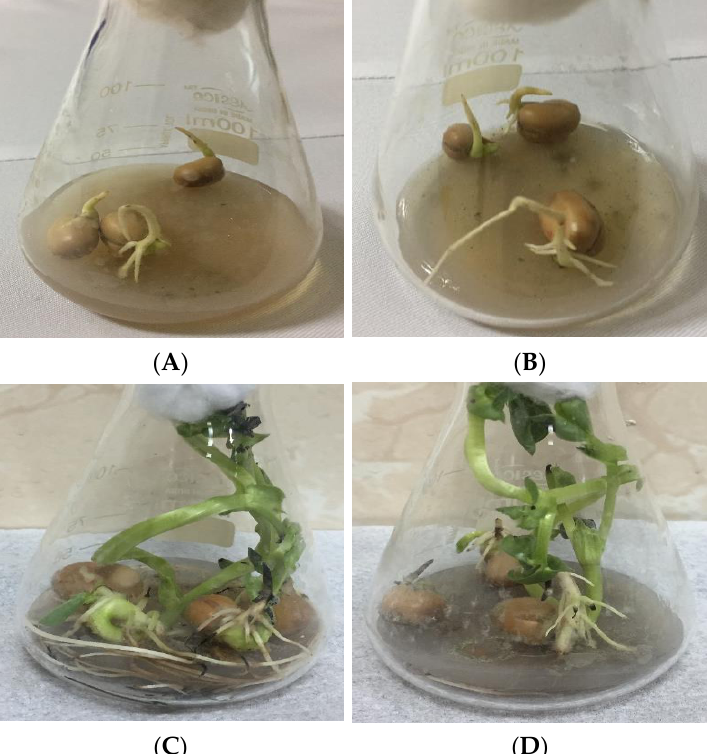
Figure 5. Effect of nano-metal complex on Vicia faba seedlings grown in Earlenmeyer flasks containing 2% water agar. ( A ) control after 4 days; ( B ) treated seeds with nano-metal complex (20 ppm) after 4 days; ( C ) control after 20 days; ( D ) treated seeds with nano-metal complex (20 ppm) after 20 days at 25 °C.